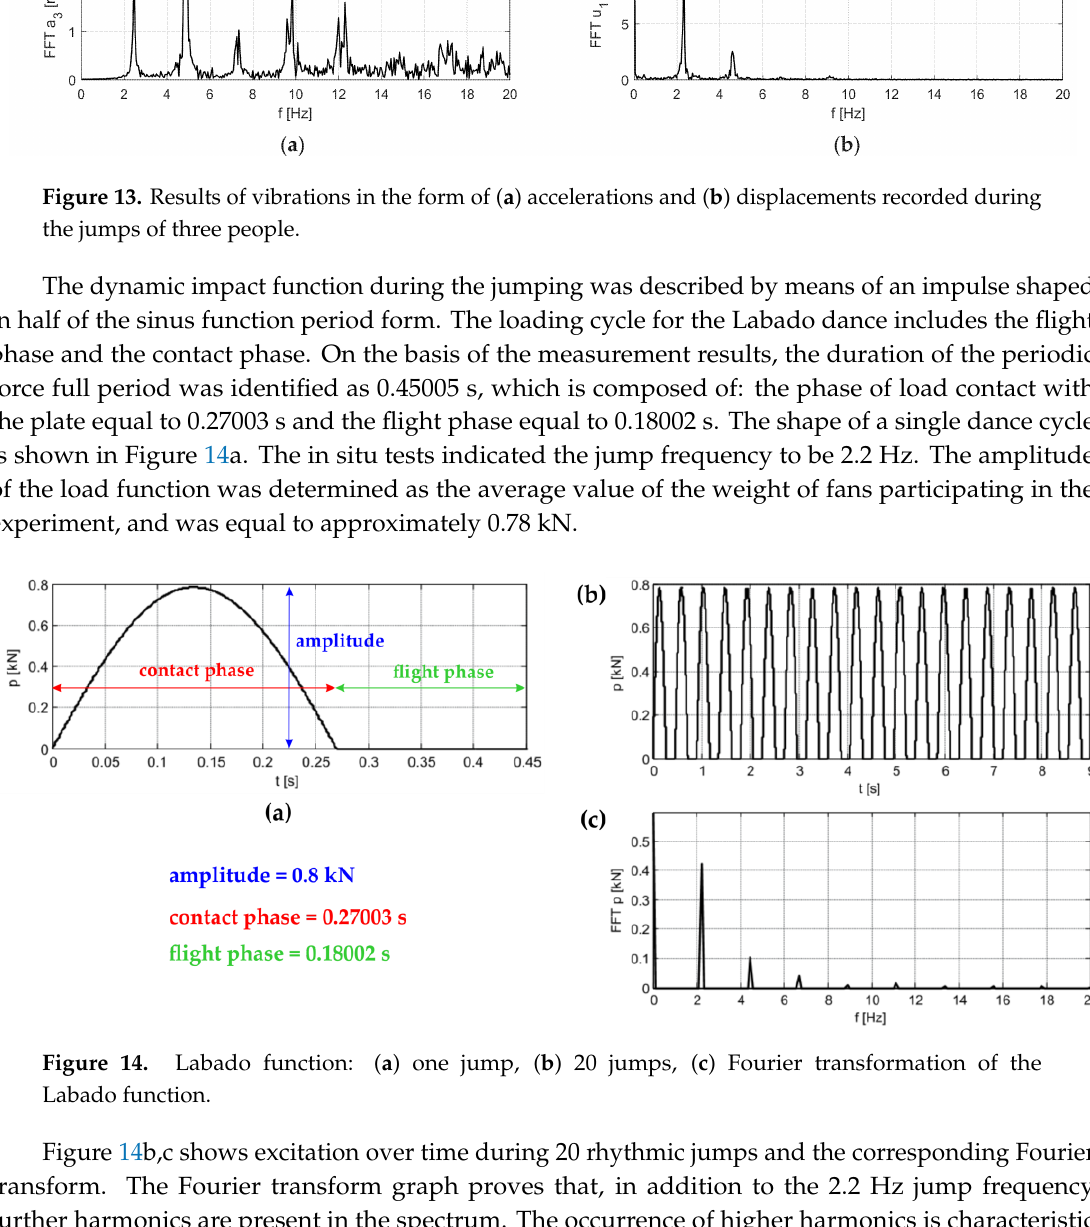
Figure 15. Numerical simulations of the implementation of excited vibrations in the form of rhythmic jumps performed by: ( a ) one person, ( b ) two people, ( c ) three people .